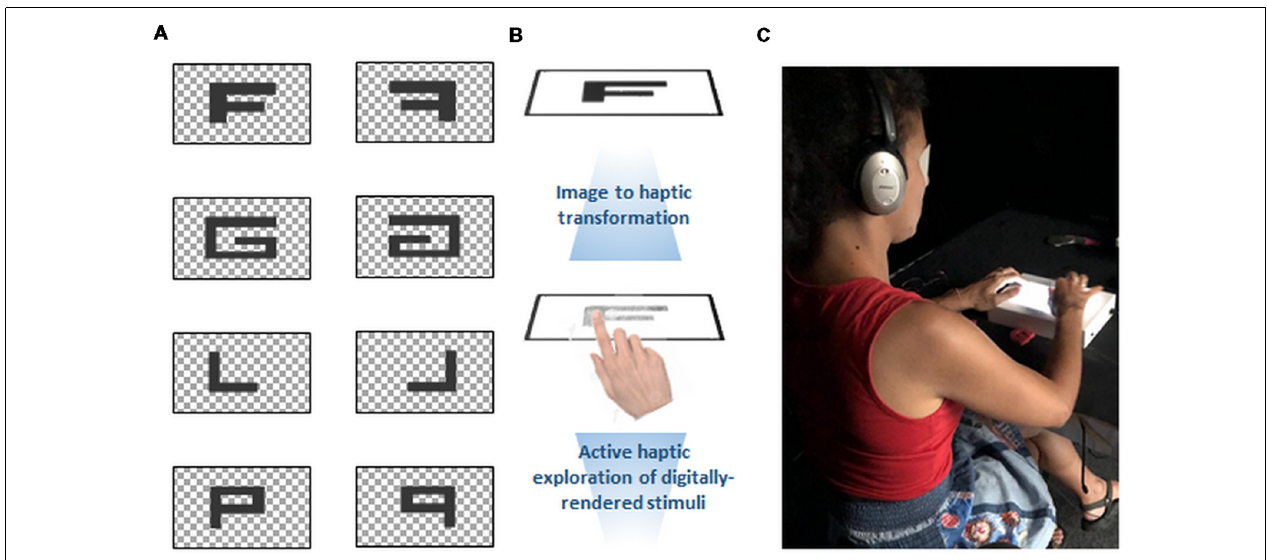
FIGURE 1 | (A) Stimuli used in the experiment. These images are based on reverse translation of the haptic “image.” The checkered portions refer to regions with no haptic texture. The letters were created to have the same proportions on the haptic tablet screen, and thus they appear slightly distorted. Normal stimuli and their mirror images were rotated at 90 ◦ , 180 ◦ , 270 ◦ and were individually presented to participants on the tablet. (B) Transformation of the stimuli into haptic renderings was possible via a pre-installed kit. The transformation takes a cell (8 × 8 pixels) from the picture file and codes the cells into textures with the help of a haptic library where different textures are defined. Participants were then able to feel the vibrations on the tablet screen only at those places where the cells were transformed. (C) Experimental setup. Participants had their eyes blindfolded and wore noise-canceling headphones in order to prevent any other external stimulation interfering with the haptic sensation. After exploring the letter on the tablet for 30 s with a single finger, they indicated if the letter was normal or mirrored via a computer mouse button-press with their non-dominant hand, which would then initiate the passage to the next